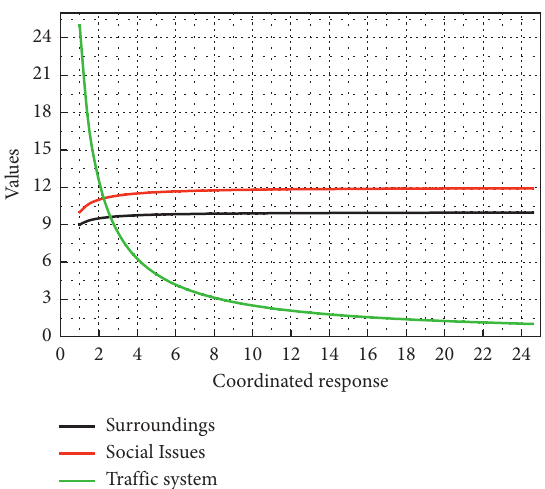
9: Coordinated response diagram of environmental and social issues to the information layer of the transportation system.